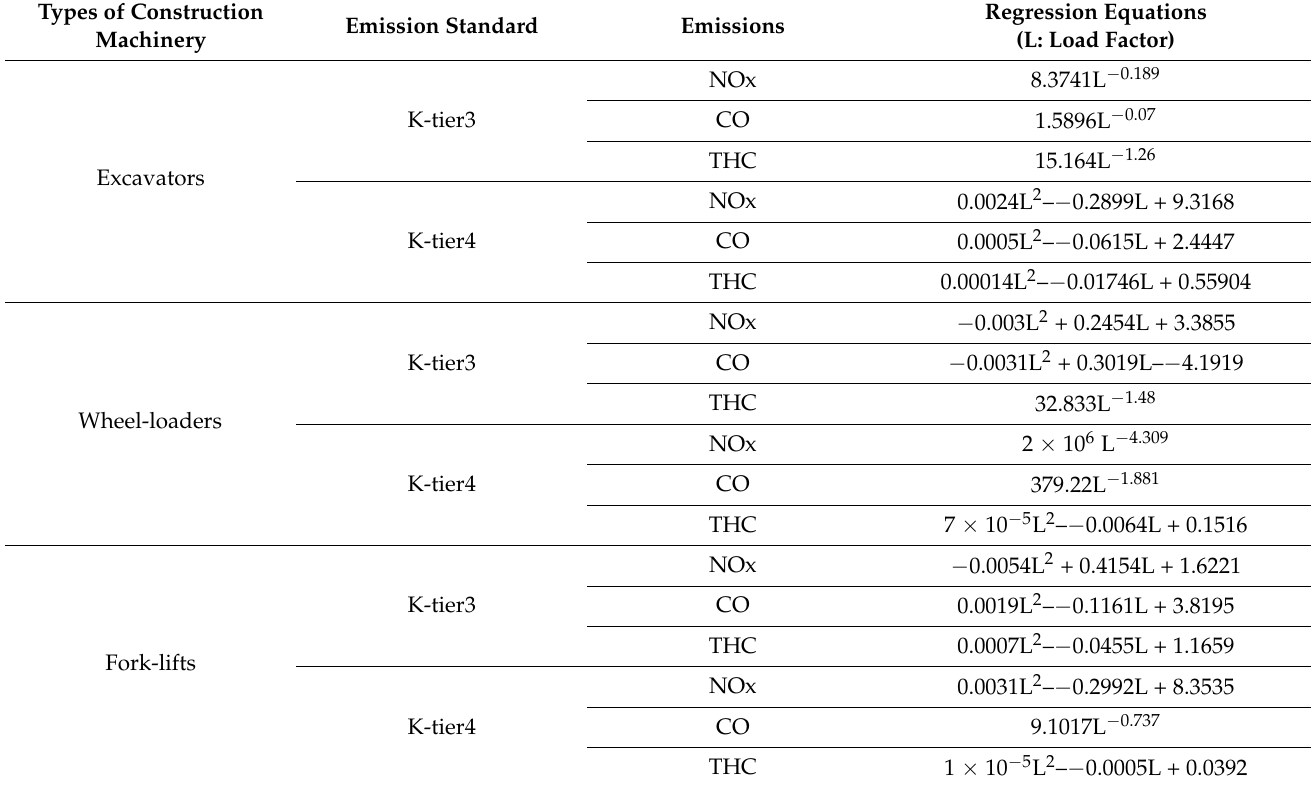
Table 5. Results of regression equations for the different type of construction